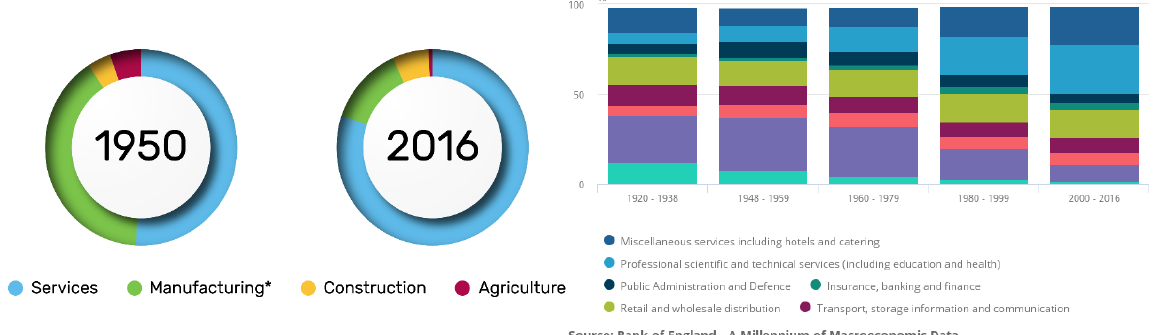
Figure 4. The changing face of UK employment. ( Left ) The UK economy by sector (in terms of output), * includes utilities and mining. ( Right ) UK sectoral shares of employment disaggregated by subsector, 1920–2016. Purple shows manufacturing, and blue represents services.